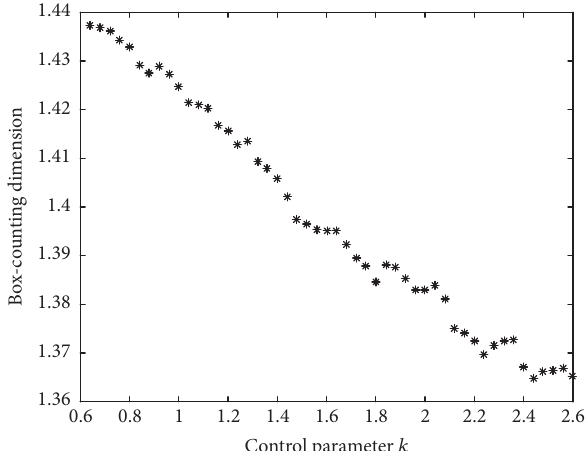
Figure 7: The change of box-counting dimensions of the Julia sets of the controlled system when 𝑘 is from 0.64 to 2.6.